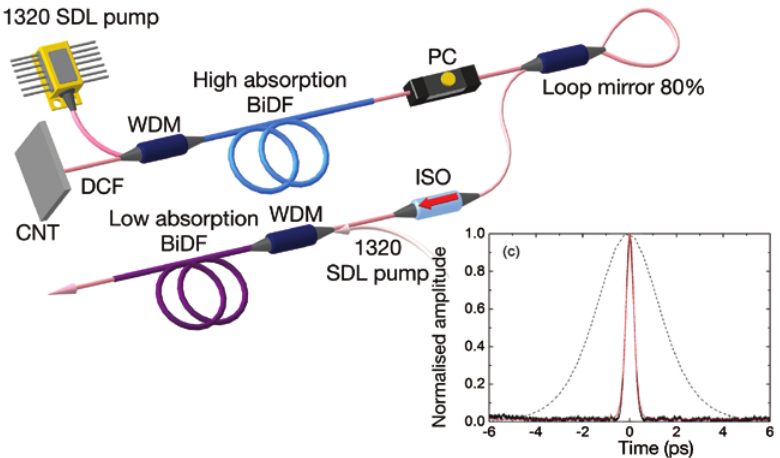
Figure 17: Setup for Bi-doped fibre MOPA. BiDF, Bismuth-doped fibre; WDM, wavelength division multiplexor; PC, polarisation controller; ISO, isolator. Inset: Autocorrelation traces before and after the compression in bismuth fibre amplifire. Adapted from